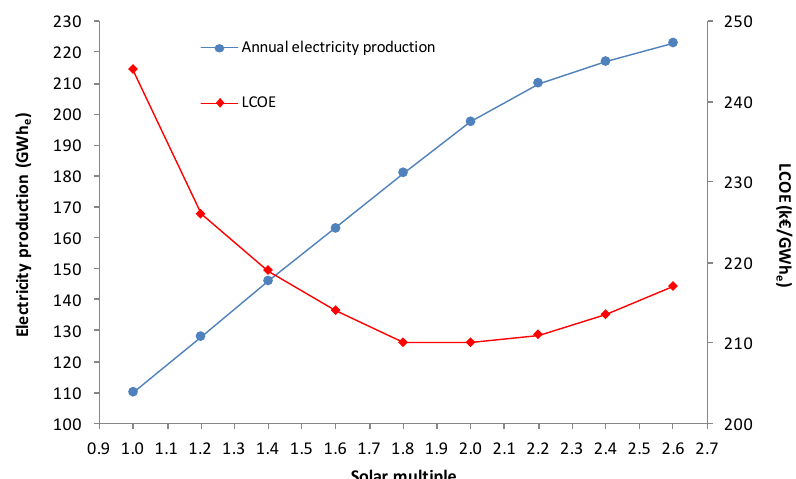
Energies 2019 , 12 , x FOR PEER REVIEW Figure 9. Annual net electricity generation and LCOE as SM function for Area 1, Vittoria.